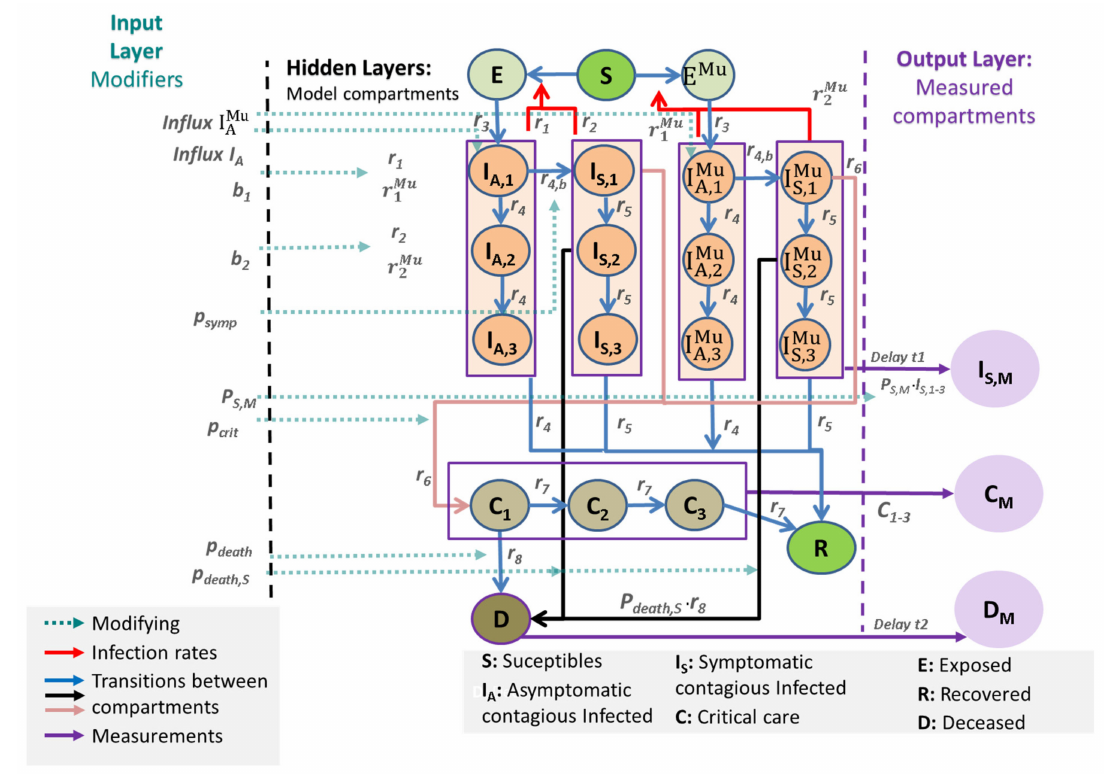
Figure 1. General scheme of our IO-NLDS model. The epidemiologic SECIR model is integrated as a hidden layer. Respective equations are provided in Appendix A. The input layer consists of external modifiers including parameter changes due to changes in testing policy, non-pharamceutical interventions, and age-structures. The output layer is derived from respective hidden layers via stochastic relationships (see later). The output layer is compared with real-world data. The superscript Mu denotes new virus variants.